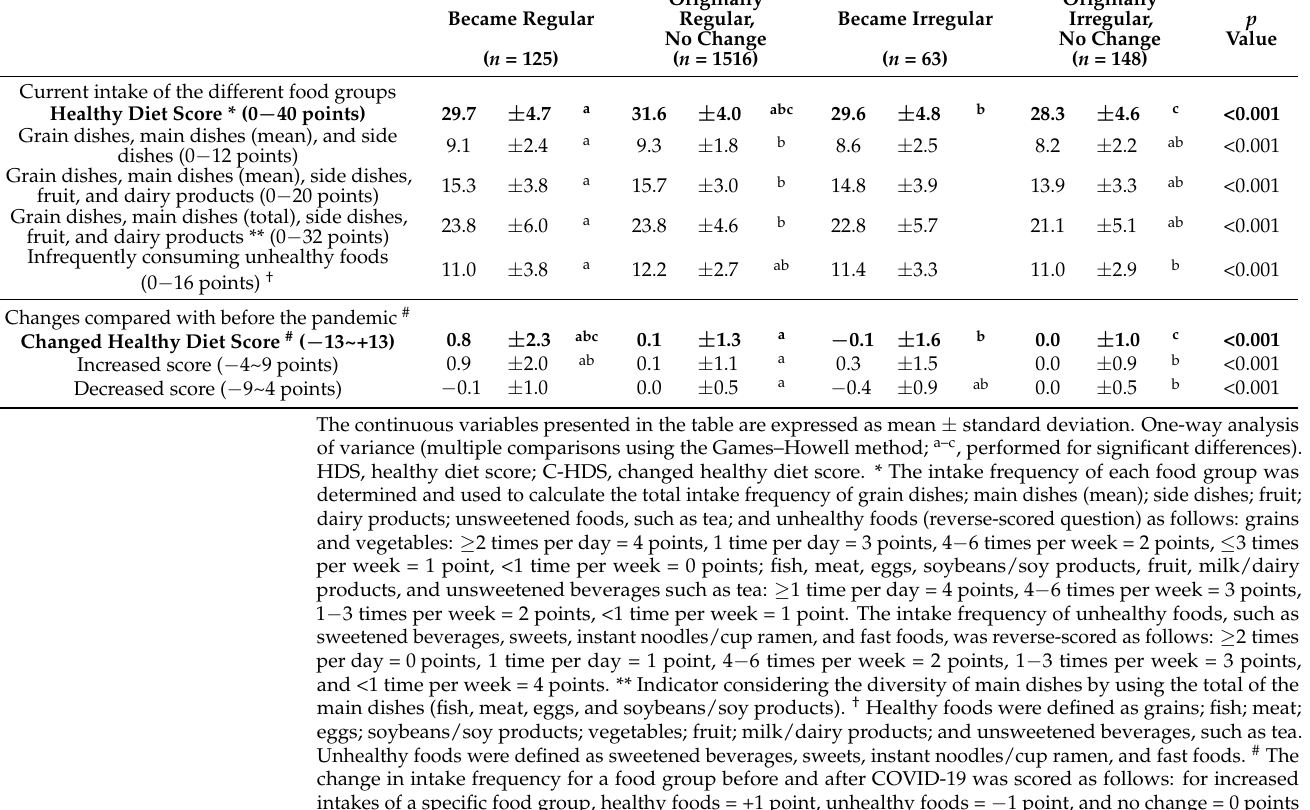
Table 3. Comparison of healthy diet score (HDS) according to changes in mealtime regularity compared with before COVID-19.